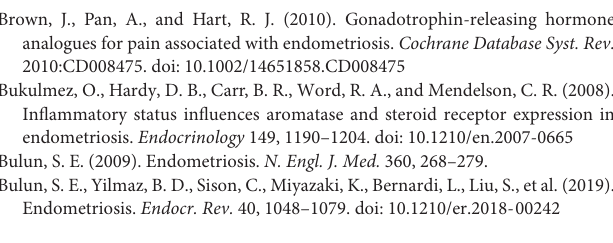
Supplementary Figure 1 | Representative images of immunohistochemical staining and fluorescence staining in Figure 1 . (A) The immunohistochemical staining of ER α and ER β in human and mouse endometriosis/normal tissues. (B) The fluorescence staining of Ki67 in human and mouse endometriosis/normal tissues. (C) The immunohistochemical staining of cleaved caspase-8 in human and mouse endometriosis/normal tissues. Supplementary Figure 2 | Representative images of immunohistochemical staining and fluorescence staining in Figures 4 , 5 . (A) The immunohistochemical staining of BAG2 in human and mouse endometriosis/normal tissues. (B) The fluorescence staining of BAG2 and CHIP in cells. (C) The immunohistochemical staining of MDM2 in human and mouse endometriosis/normal tissues. (D) The fluorescence staining of MDM2 and ER α in